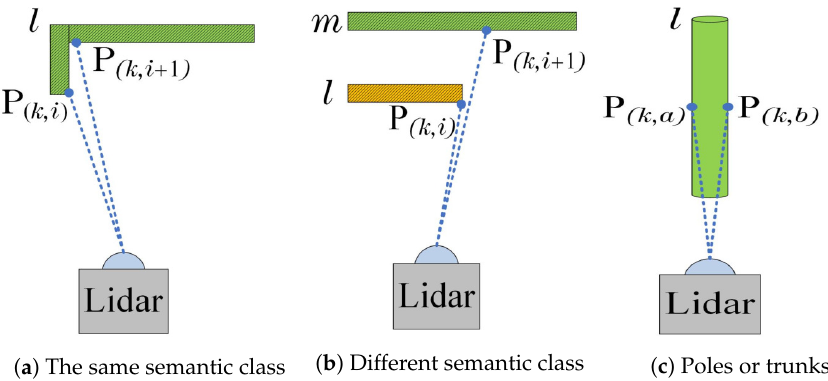
Figure 2. Three different cases where the edge points are extracted. The dotted blue line segments represent the laser beam of the same scan line. The green shapes denote objects in the real environ- ment. Furthermore, the yellow shape in ( b ) is an object, which occludes the green object behind. ( a ) Points in the same semantic category. ( b ) Points on the boundary of different semantic categories. ( c ) Points on cylinder objects, e.g., poles and